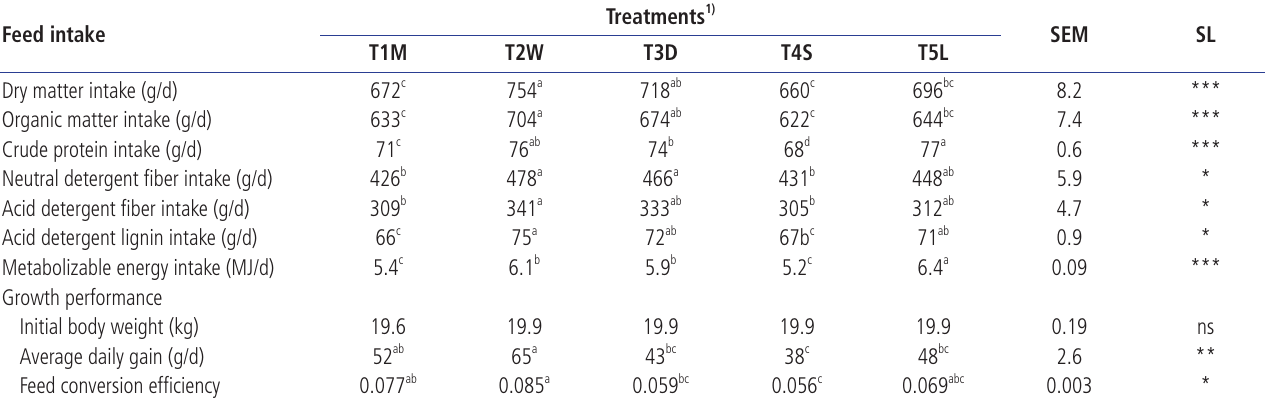
Table 4. Feed intake and fattening performance of Arsi-Bale sheep fed diet containing different varieties of faba bean straw (70%) and concentrate (30%) Feed intake